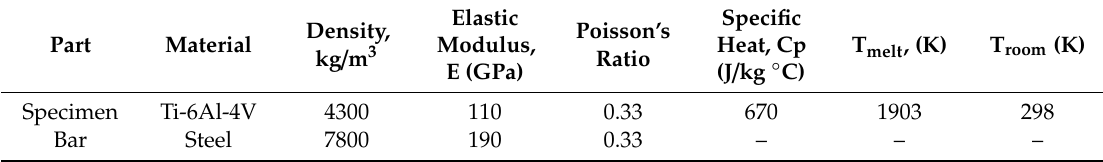
Table 1. Material properties used in FEA, data from